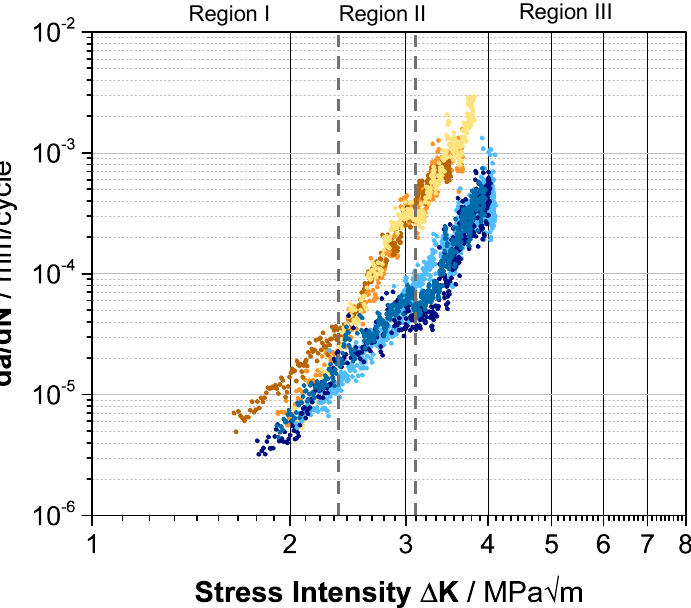
Figure 7. FCP behavior of the PET control (light blue, blue, dark blue) and PET*96 h (yellow, orange, brown) samples in a double logarithmic scale with the division into three relevant regions, marked by the dashed lines and grey color.